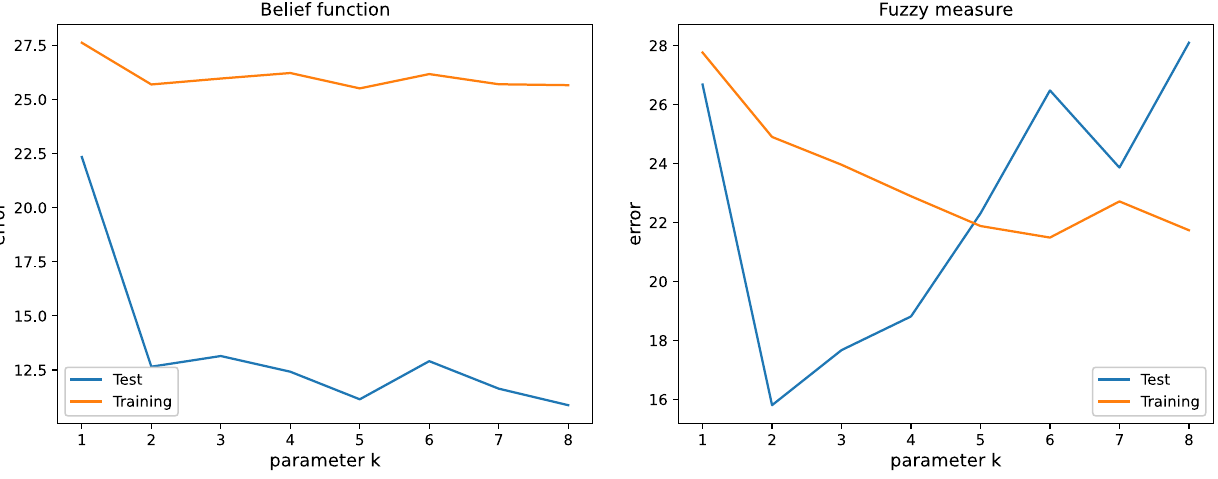
Fig. 2 Error of the objective function (Equation 9) for the training and test sets when the measure is a belief function (left) and when it is an arbitrary measure (right). We use here Equation (9) to compute the